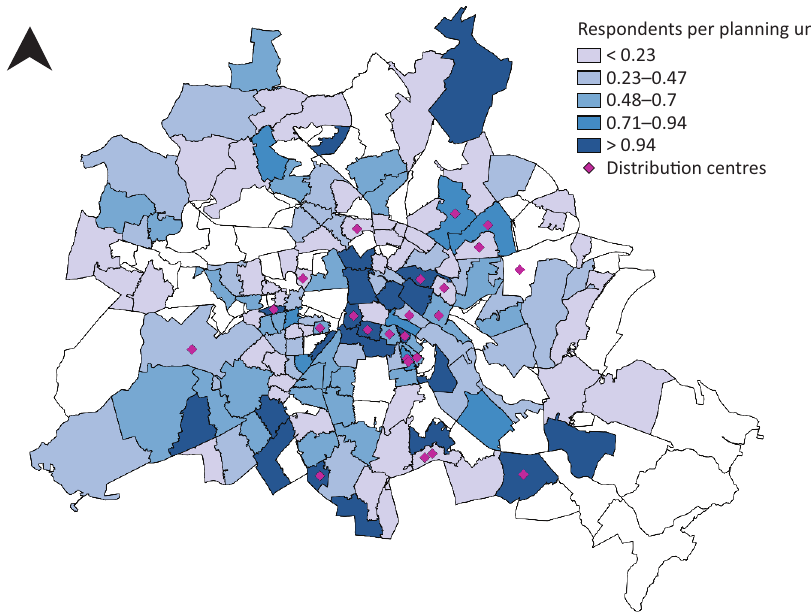
Figure 1. Distribution of respondents proportionate to all elders who answered the questionnaire and distribution centres in Berlin (Basemap: StatIS,